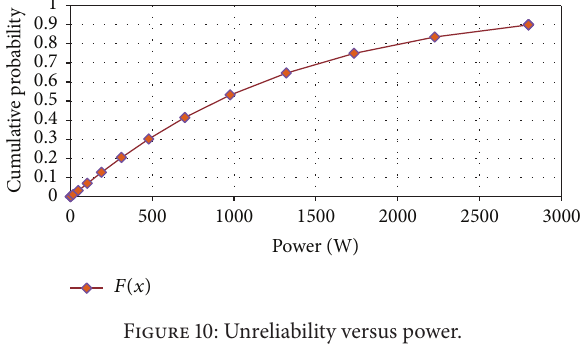
Figure 8: Unreliability estimation.